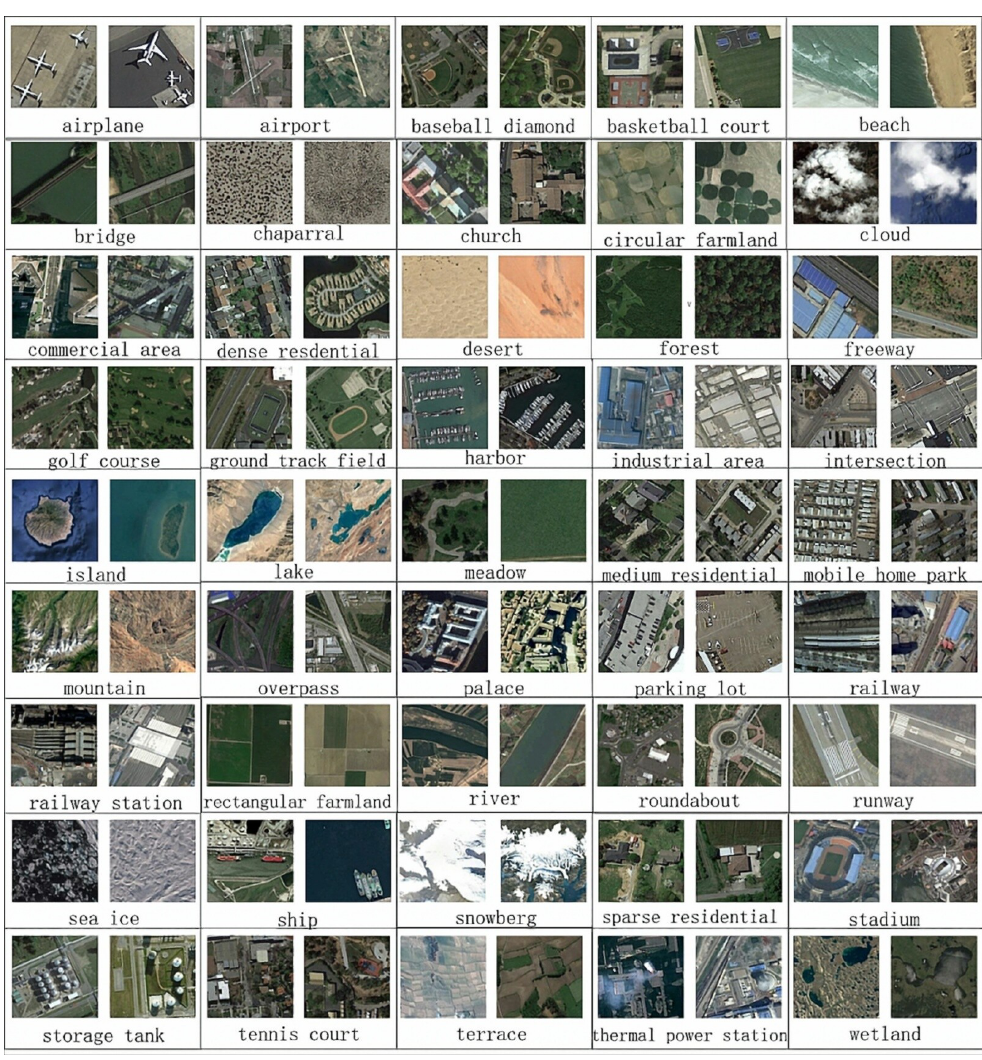
Figure 4. Images samples from